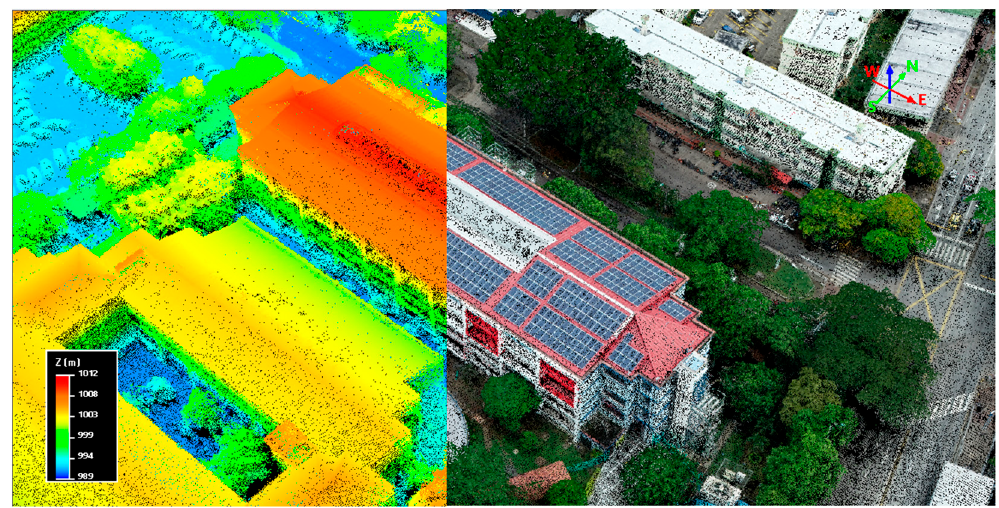
Figure 4. 3D point cloud; the left part shows the elevation, and the right part shows the natural color of the